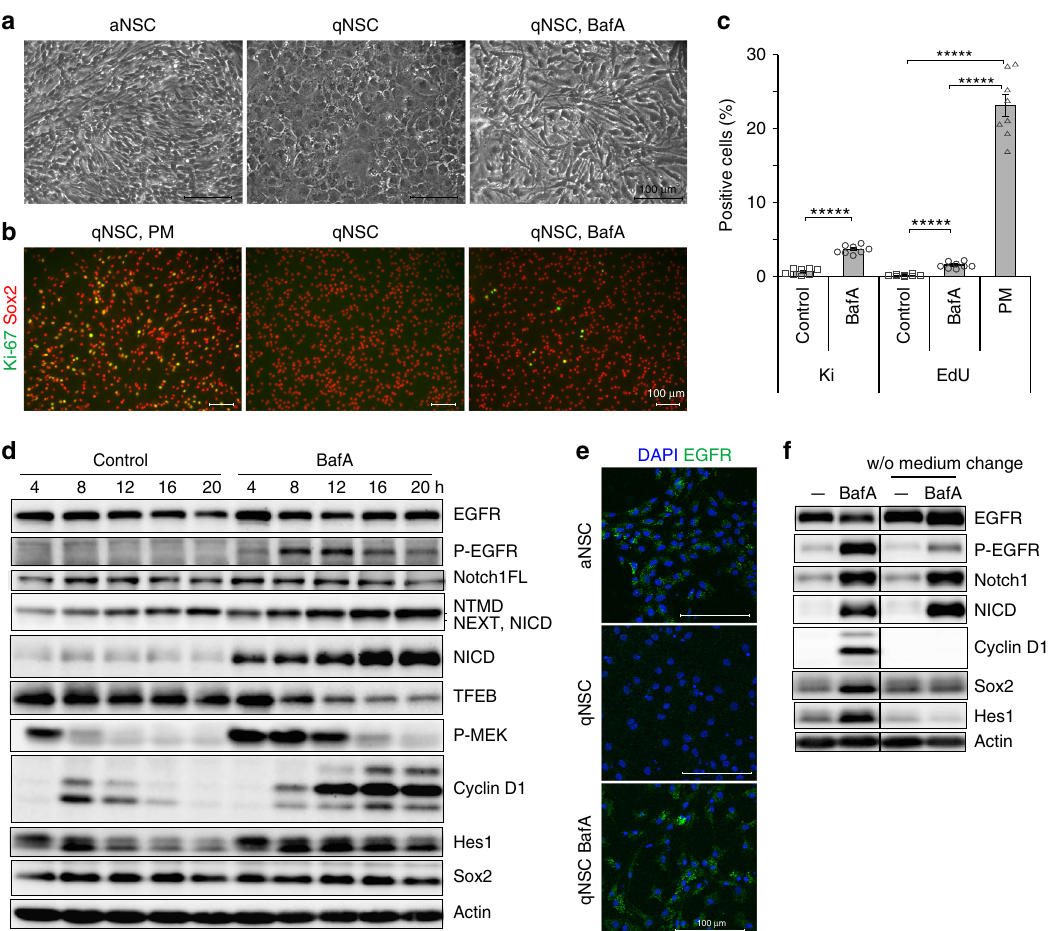
Fig. 2 Lysosomal inhibition to qNSCs. a Bright fi eld view of NSCs; bipolar proliferating NSCs (aNSC), fl at qNSCs (qNSC), and bipolar qNSCs treated with 20 nM ba fi lomycin A (qNSC, BafA). b Immunocytochemistry of Ki-67. Representative view of NSCs immunostained for Ki-67 (green) and Sox2 (red). qNSCs were incubated in proliferation medium containing EGF (qNSC, PM), quiescence medium (qNSC), or quiescence medium containing BafA (qNSC, BafA) for 1 day, and then analyzed. c Percentage of Ki-67 – positive (Ki) or EdU-incorporated (EdU) cells. Results are averages of eight samples of qNSCs (control), BafA-treated qNSCs (BafA), or qNSCs after incubation with proliferation medium (PM); n = 8. d Immunoblotting of qNSCs after incubation with qNSC medium (control) or qNSC medium containing BafA (20 nM) (BafA) for 4 – 20 h. e Immunocytochemistry of EGFR. BafA-treated qNSCs accumulated EGFR (green) in the cytoplasm. EGFR on the cell surface was not detected by immunostaining following membrane permeabilization. This might be responsible for the differences between the results of immunostainings and western blotting. f Effect of medium change. Samples on the left sides of blots were incubated in fresh quiescence medium, with or without BafA. In the w/o medium change samples, the medium in culture dishes was partially removed and added back with or without addition of BafA. Scale bars, 100 µ m. Data represent means± s.e.m. (***** P < 0.0001; Student ’ s t -test). Source data of immunoblots are provided as a Source Data fi